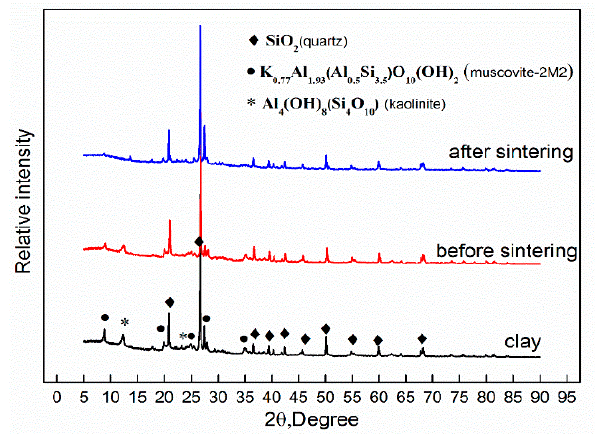
Figure 4. The XRD patterns of clay and graphene bricks before and after sintering.